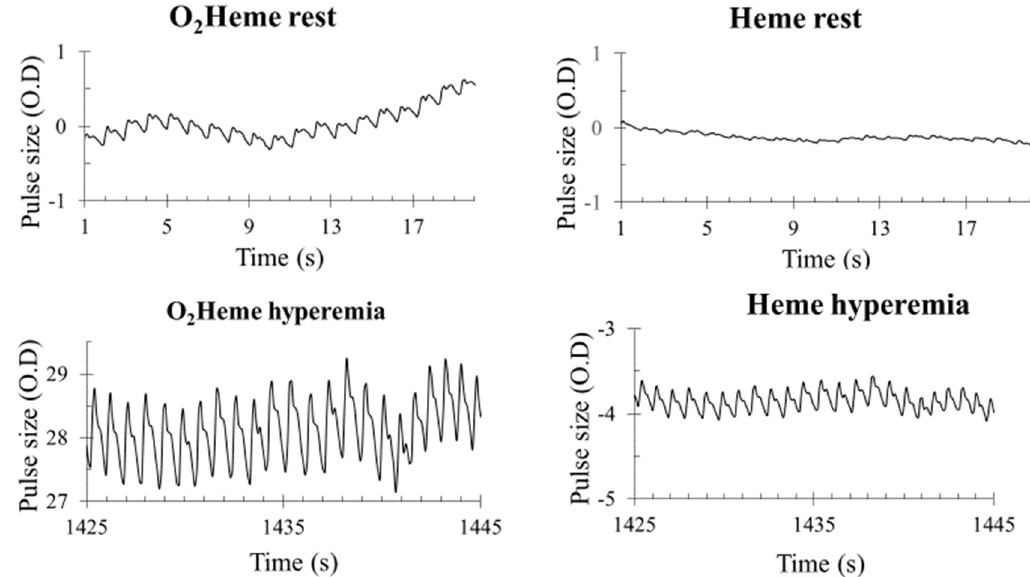
Figure 4. Examples of blood flow pulsations of O 2 heme and Heme signals at rest and during peak reactive hyperemia. The y -axis scale is in optical density units.